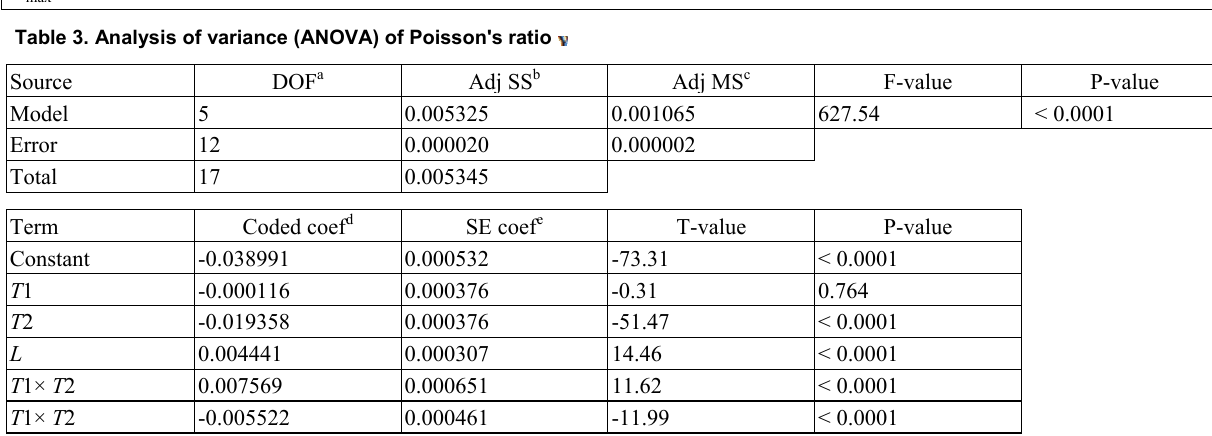
Table 3. Analysis of variance (ANOVA) of Poisson's ratio